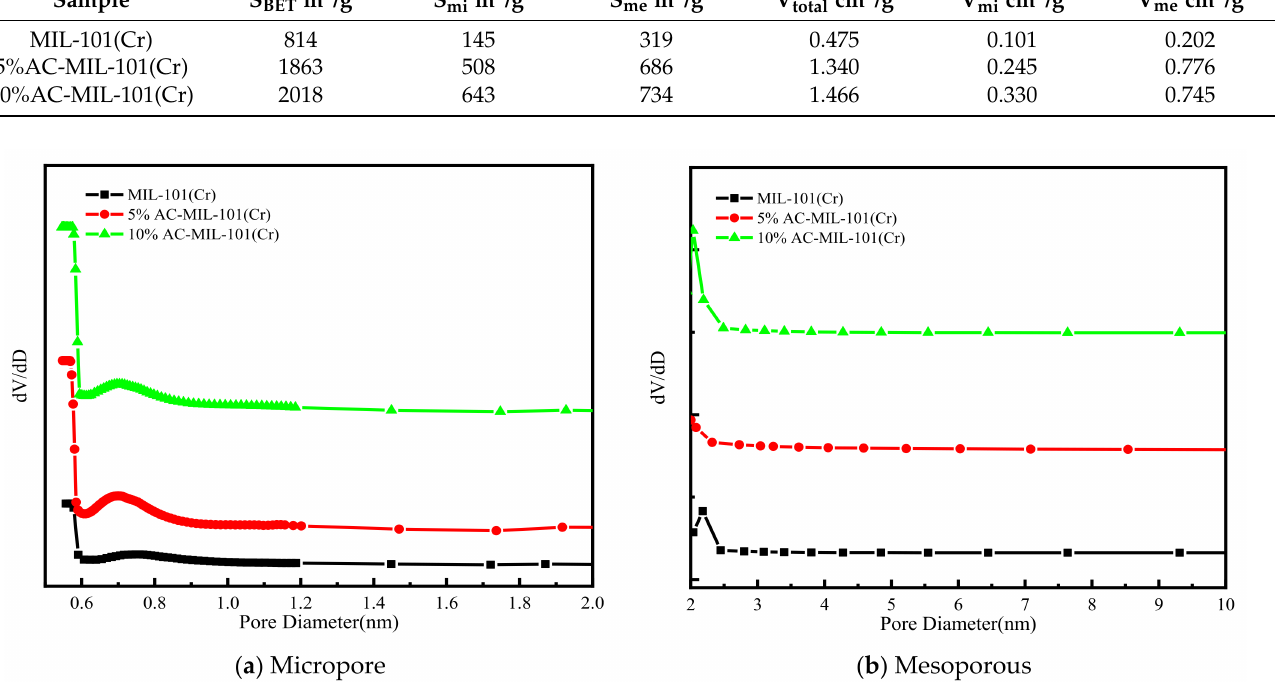
Figure 6. Pore diameter distribution of MIL-101(Cr) and AC-MIL-101(Cr): ( a ) micropore; ( b )